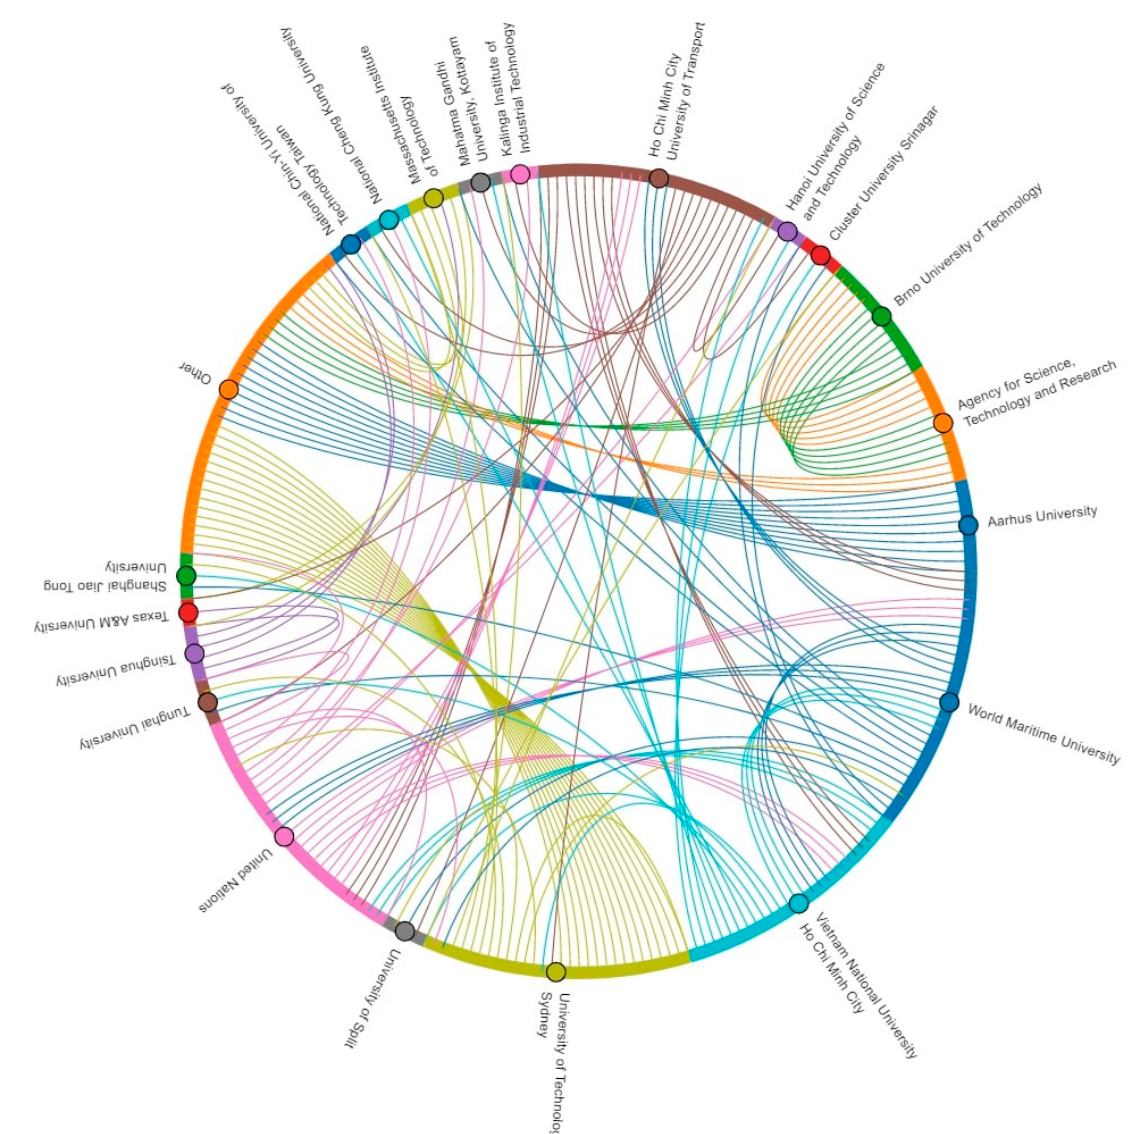
Figure 3. A chord diagram of top networks that appeared within energy (subject area: renewable energy, sustainability, and the environment), 2019–2021. Source: based on the SciVal database